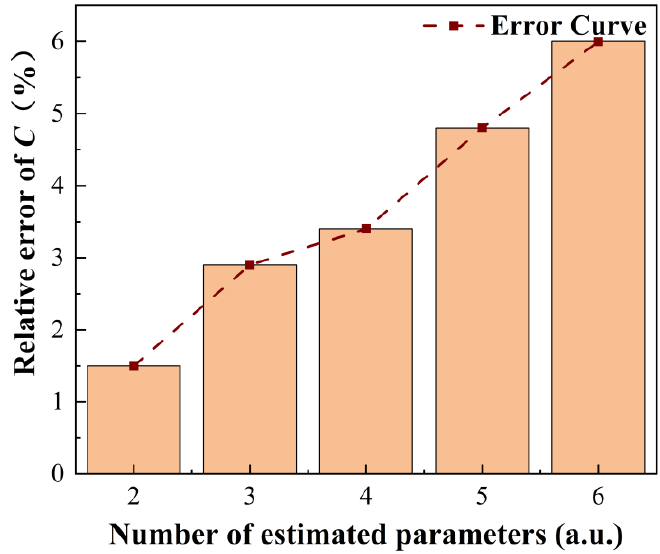
Figure 2. The relative error of concentration under different numbers of parameters in the model. Table 2. Comparison results under a different number of estimated